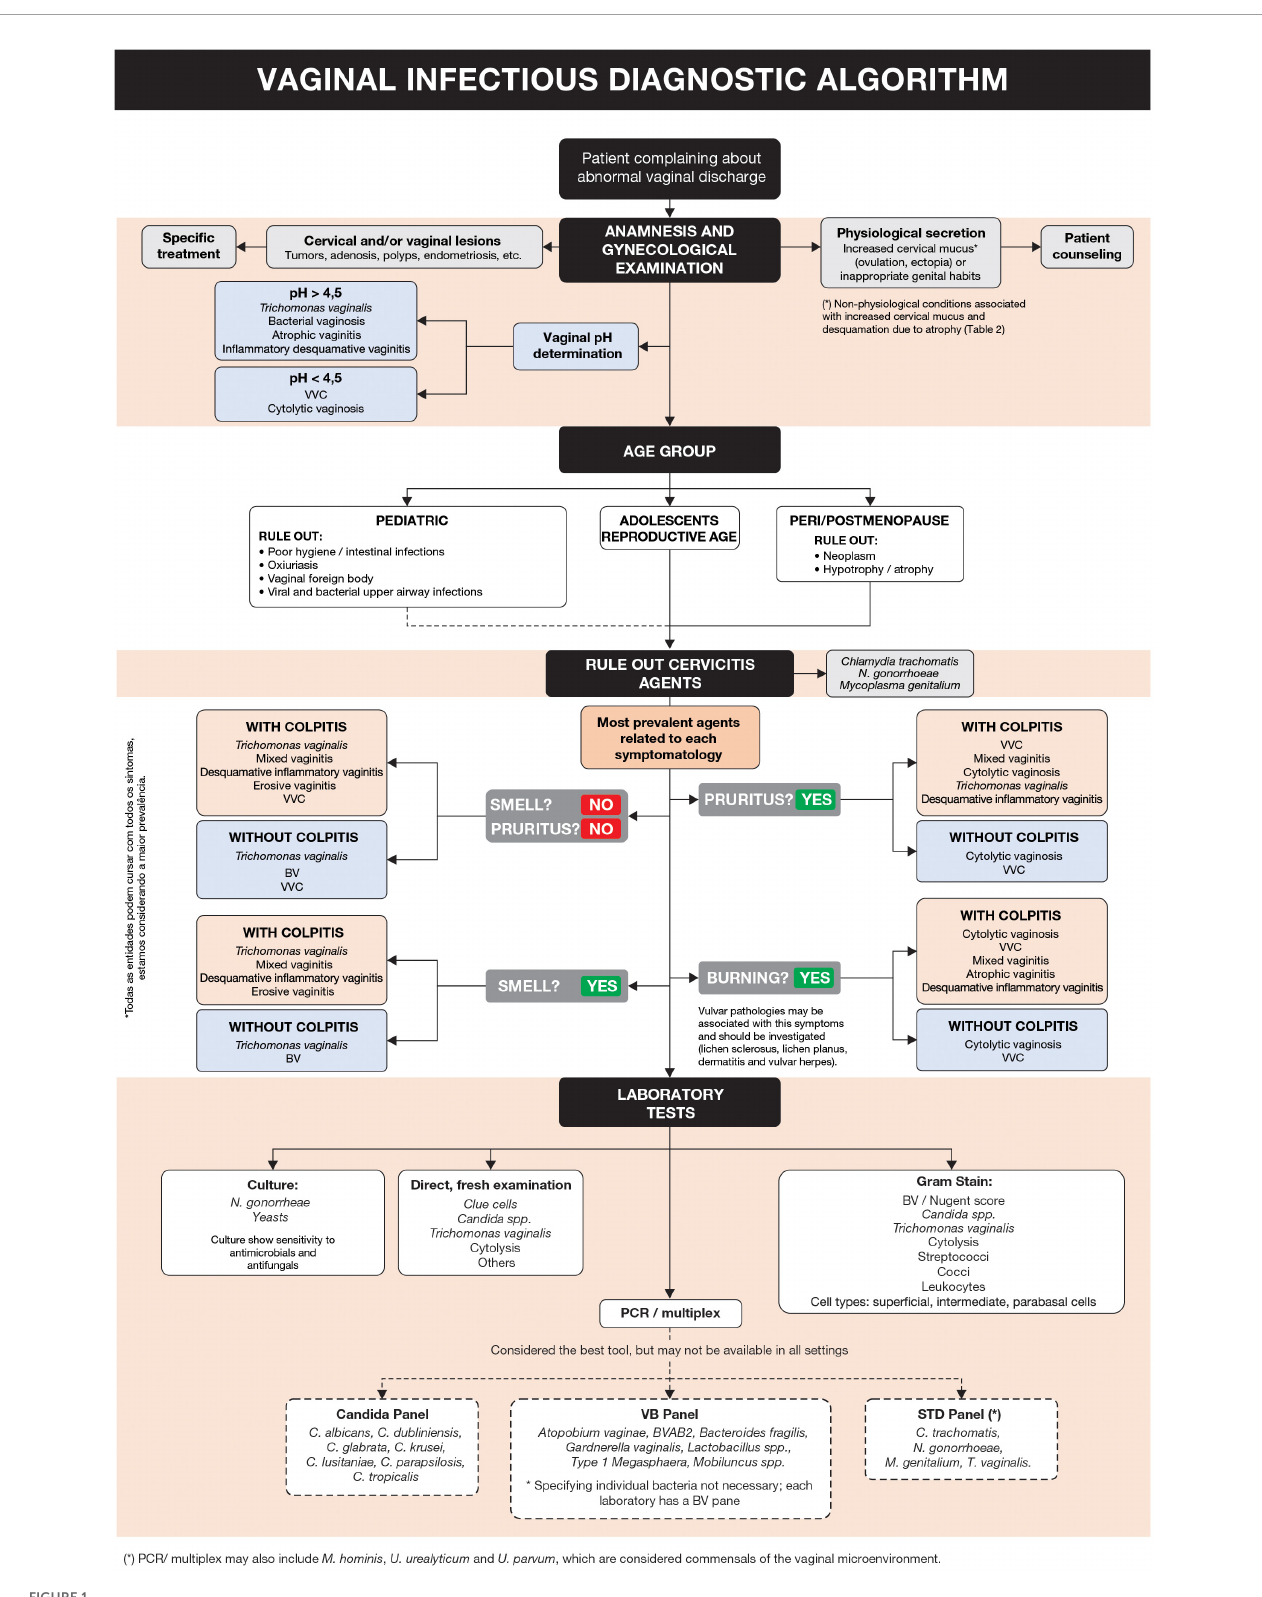
FIGURE1 Vaginal infectious diagnostic algorithm.